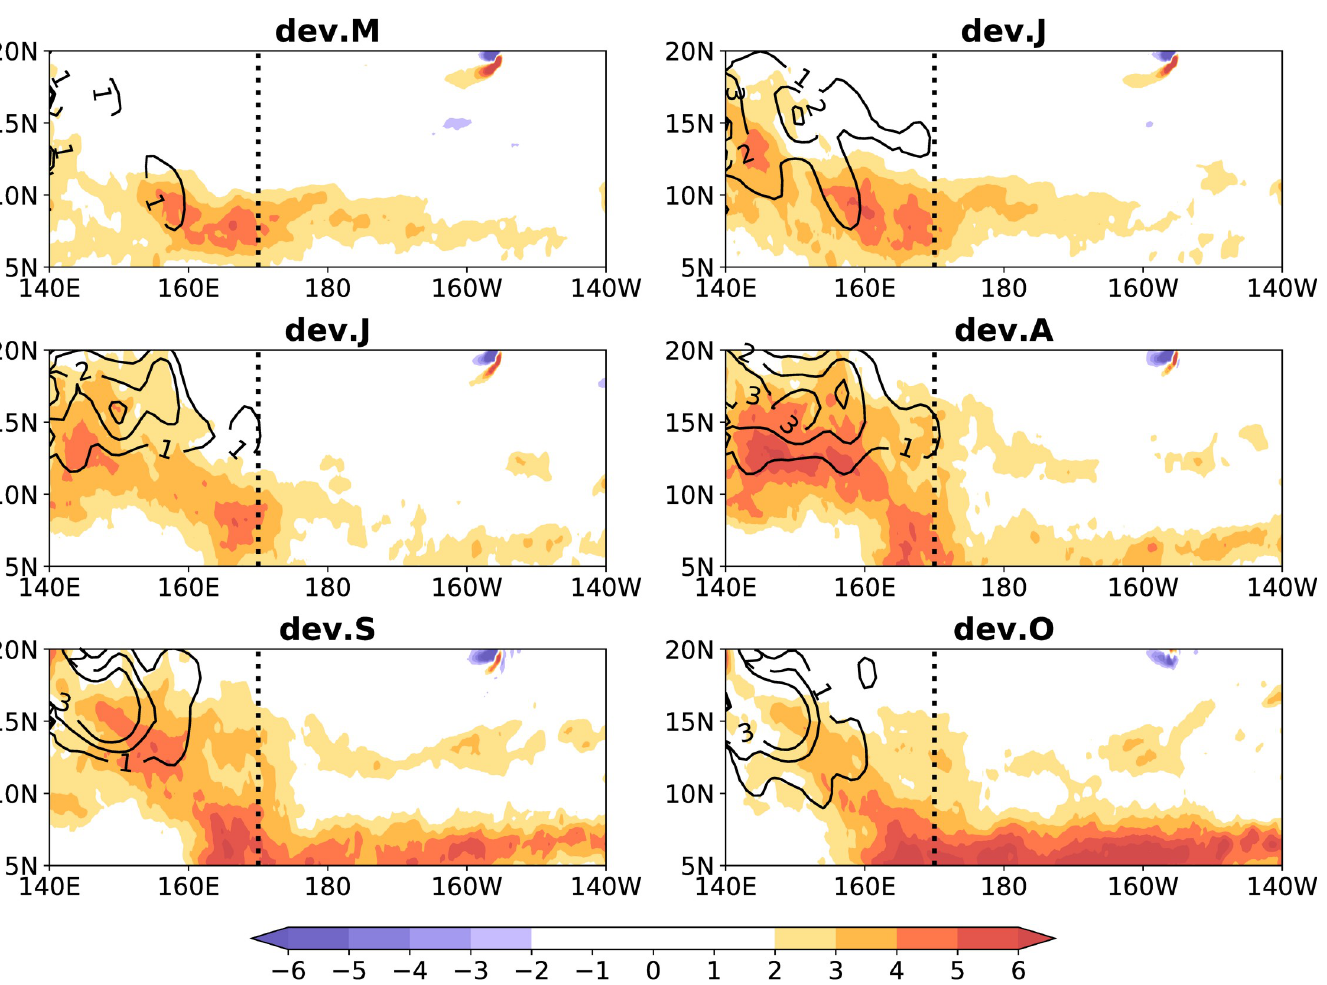
Fig 9. Link between the eastward extension of the monsoon trough and tropical cyclone activity. The shaded area indicates the composite monthly relative vorticity anomaly (10 − 6 s -1 ) at 850-hPa from May to October during eight El Ni ñ o developing years. The black dotted line indicates 170˚E, and the contour indicates the ACE anomaly (10 2 m 2 s -2 ) of tropical cyclones. Title dev. M-O indicates the period from May to October during El Ni ñ o developing years.